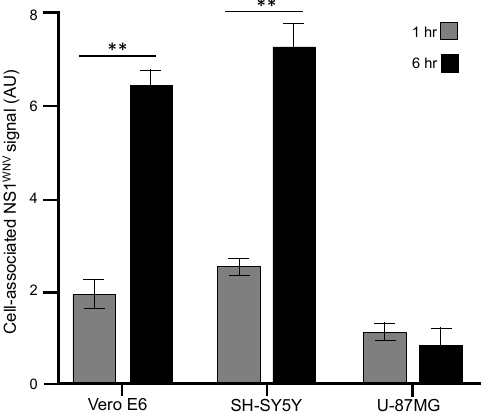
Figure 3. Cell attachment and uptake of recombinant sNS1 WNV by different cell types. Aliquots of extracellular, H 6 -tagged sNS1 WNV protein, released by pNS1 WNV-IS98 -transfected HEK-293T cells and purified by affinity chromatography, were added to the cell culture media of Vero E6, SH-SY5Y, and U-87MG cells, at a final concentration of 10 μg/mL. In one series of samples, cells were collected after 1 h incubation on ice (gray bars) and cell-bound NS1 WNV was detected and quantified by flow cytometry. In another series (black bars), cells were first incubated on ice for 1 h, then transferred to 37 °C for 6 h, permeabilized, and intracellular NS1 WNV was evaluated by flow cytometry. Control mock-treated cells were incubated with samples from the culture medium of HEK-293T cells transfected with empty plasmid pcDNA3.1, subjected to the same chromatographic process as the culture supernatant of pNS1 WNV-IS98 -transfected cells. The mean fluorescence intensity (MFI) values shown in the bar graph (expressed in arbitrary units; AU), represented the mean values ( m ± SD ) of duplicate samples from two separate experiments, corrected by subtraction of the values of the signal obtained with mock-treated cells. Statistical analyses were performed using the Mann–Whitney test. Note: ** = P ≤ 0.01.